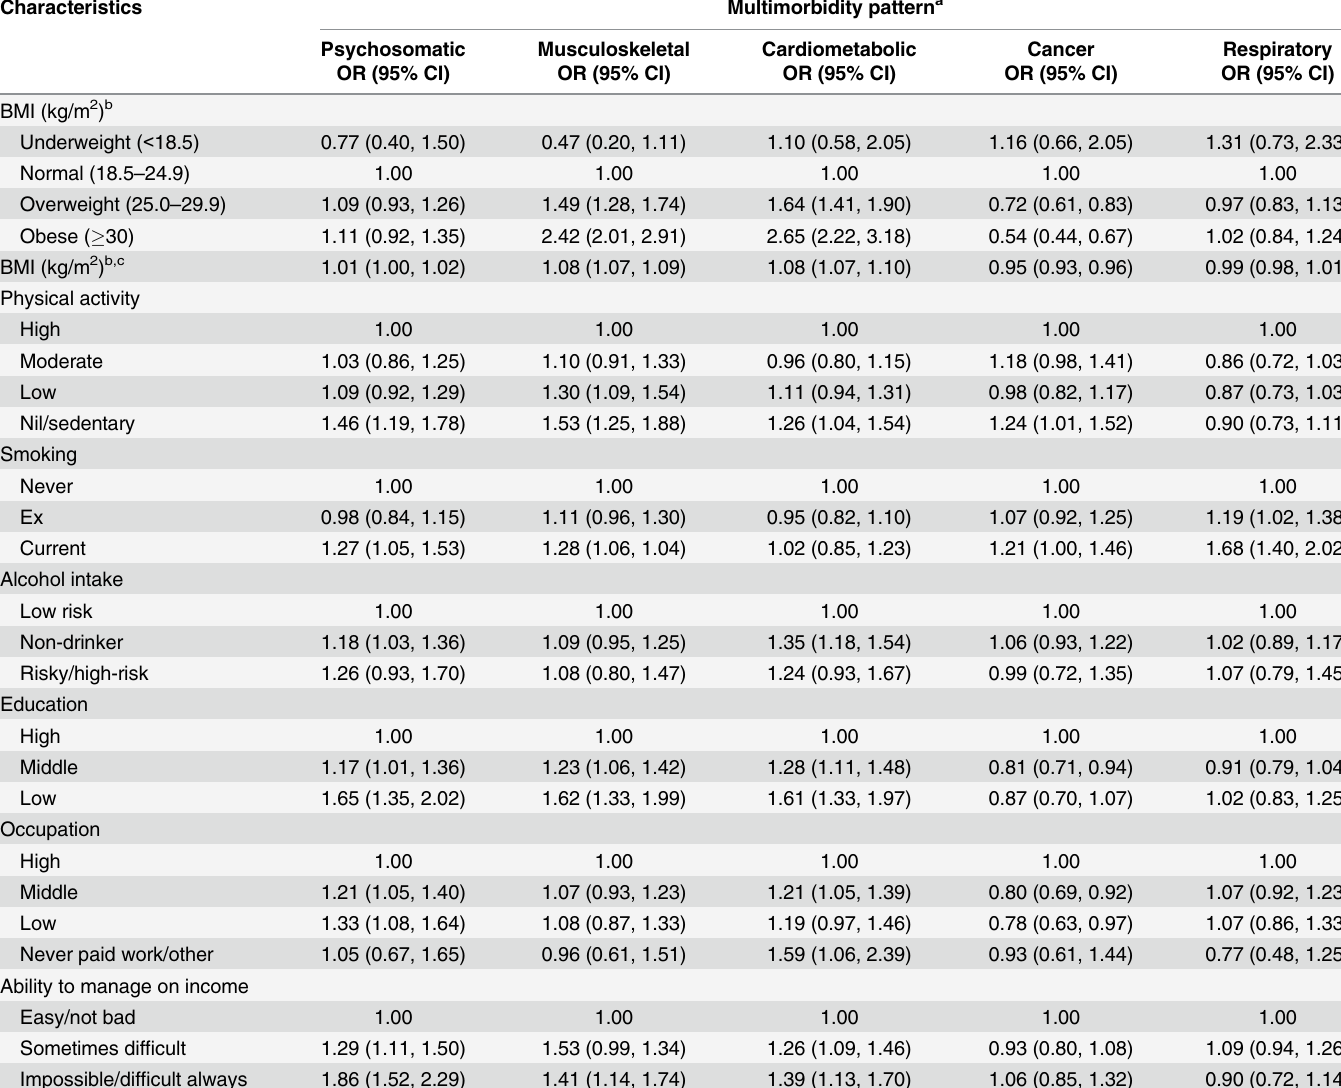
Table 4. Unadjusted ORs of the association between characteristics and a high versus low multimorbidity pattern score. Characteristics Multimorbidity pattern a